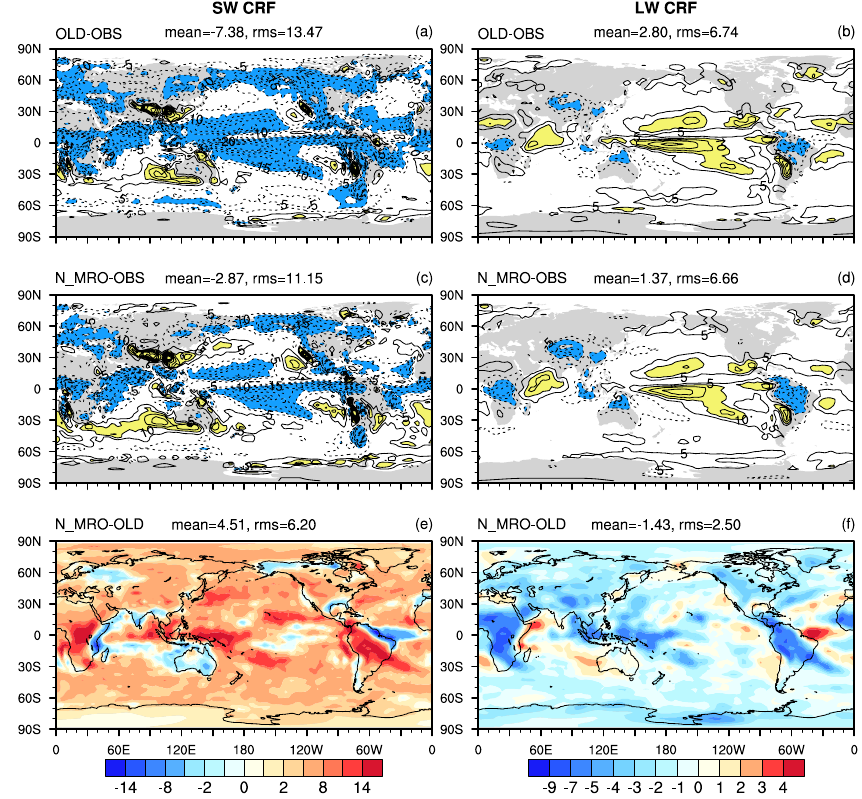
Fig. 3. The annual mean differences in SW CRF (left) and LW CRF (right). Differences larger (smaller) than 10 ( − 10)Wm − 2 are shaded in yellow (blue). The global mean and root mean square values of each figure are also